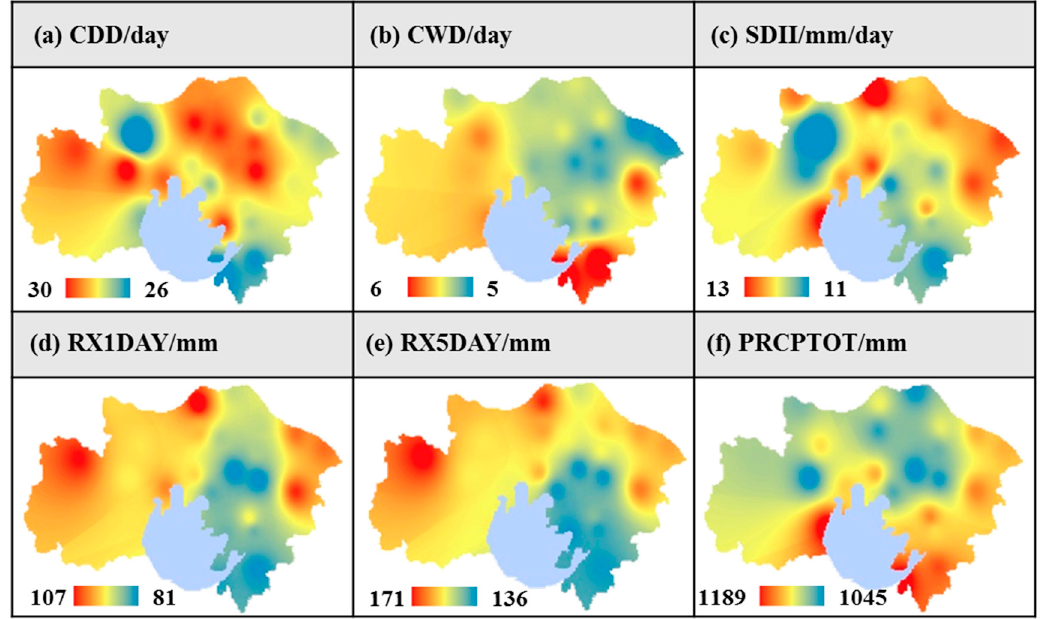
Figure 4. The spatial patterns of six extreme precipitation indices for the three urbanization levels during 1980–2015: CDD ( a ), CWD ( b ), SDII ( c ), RX1DAY ( d ), RX5DAY ( e ), and PRCPTOT ( f ).